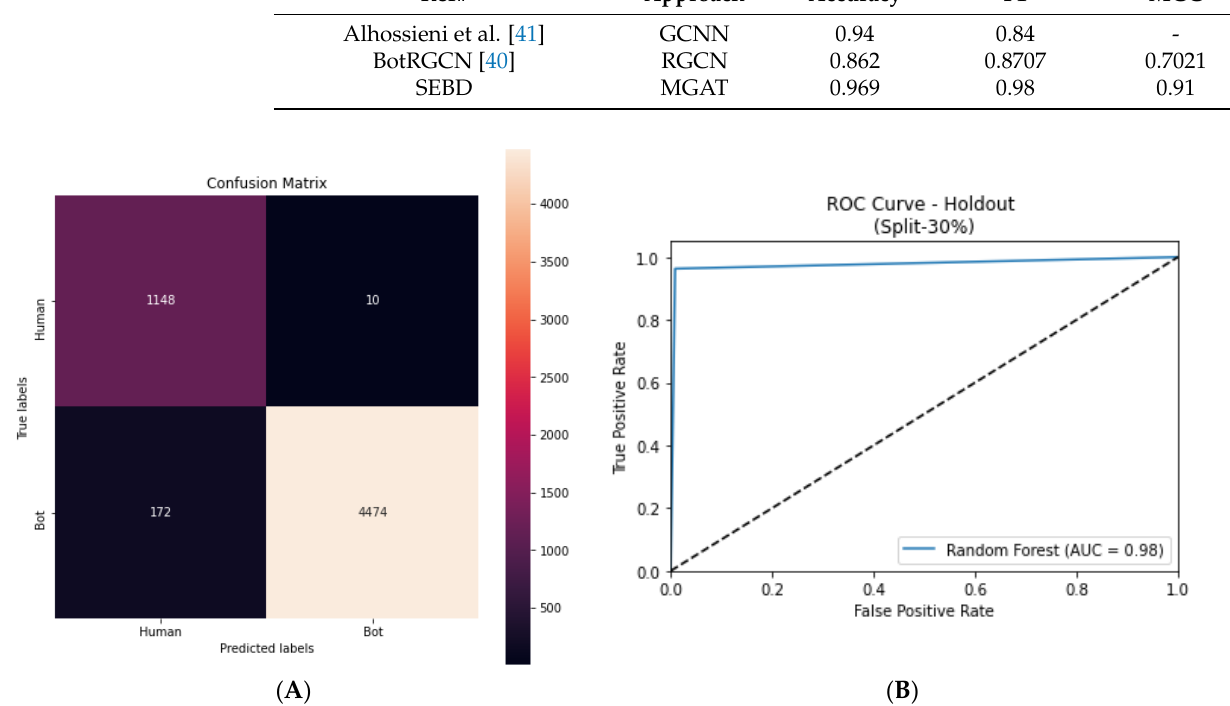
Figure 2. SEBD results using holdout method and cross - validation with random forest.